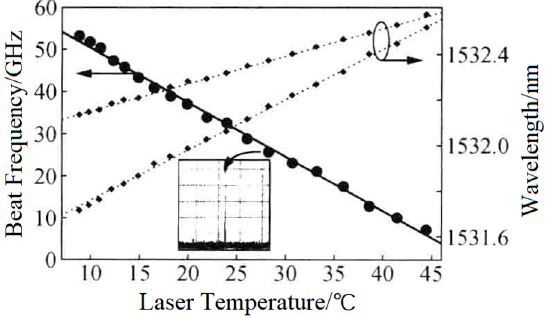
Figure 14. Dependence of oscillating wavelength and its beat frequency on laser temperature [26].